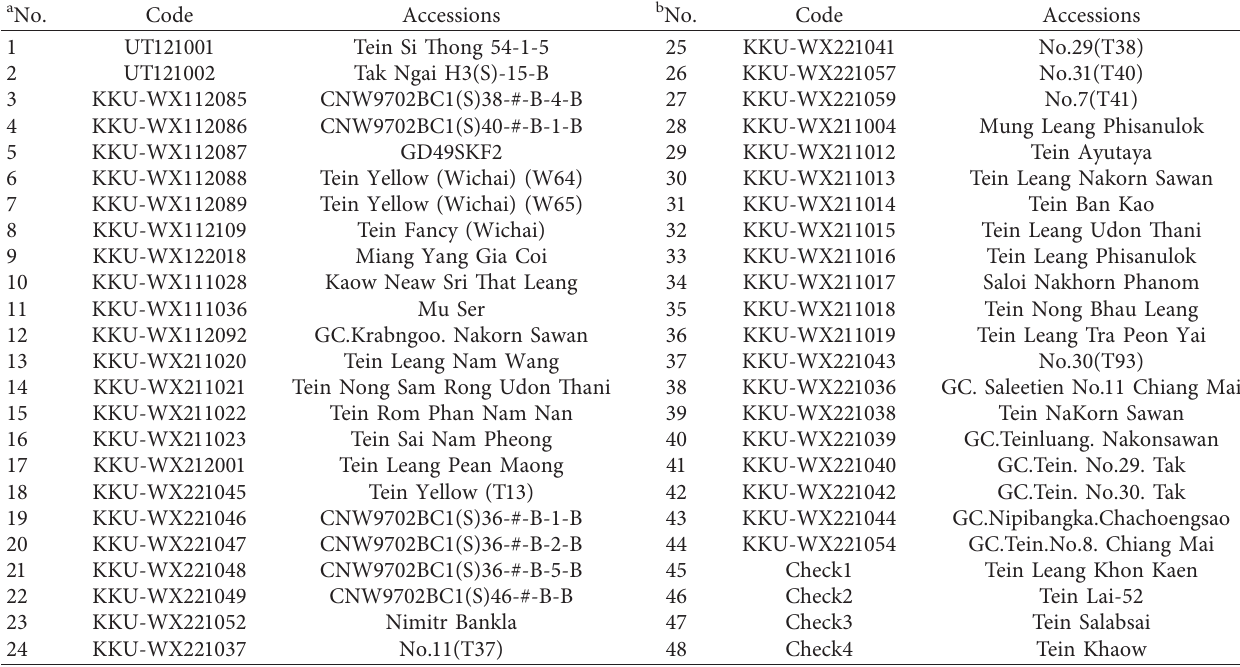
Table 1: Small-ear waxy corn accessions used in this